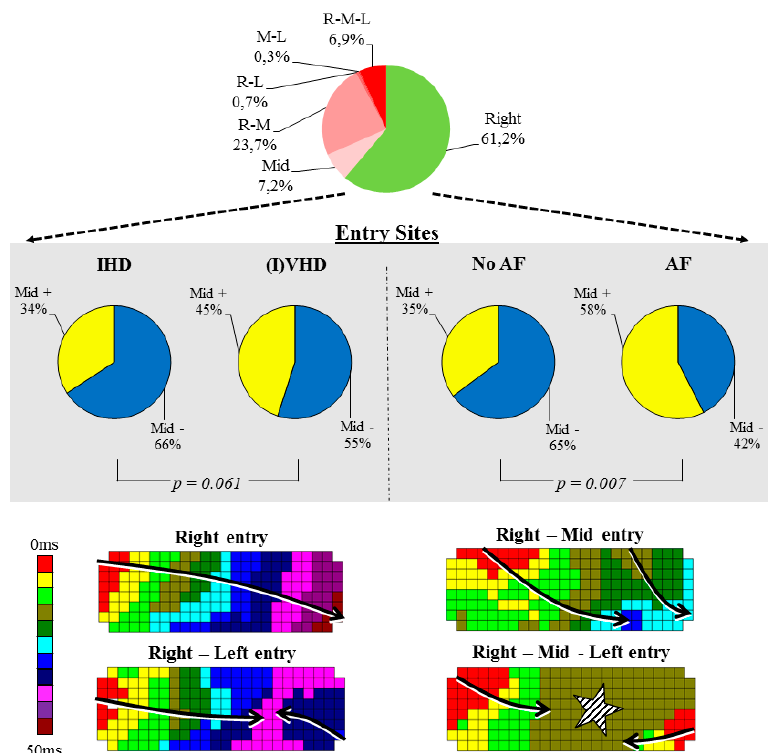
Figure 2. Entry sites and patterns of activation at Bachmann’s bundle. ( Upper panel ) Frequency pie illustrating all di ff erent entry sites in the entire study population including right entry site only (green) and other entry sites (red). ( Middle panel ) Frequency pies demonstrating the number of patients without a mid-entry site (blue) and with a mid-entry site (yellow) of wavefronts. The left panels illustrate the di ff erence for underlying heart disease, the right panels for patients with / without a history of AF. ( Lower panel ) Examples of color-coded activation maps of BB during SR demonstrating di ff erent activation patterns; entry site only from the right (left upper map), right and middle (right upper map), right and left (left lower map) and right, middle and left (right lower map). Arrows indicate the main propagation direction of wavefronts, stars an area of simultaneous excitation / focal wave. AF = atrial fibrillation; IHD = ischemic heart disease; (I)VHD = (ischemic) valvular heart disease; L = left entry; M = mid entry; R = right